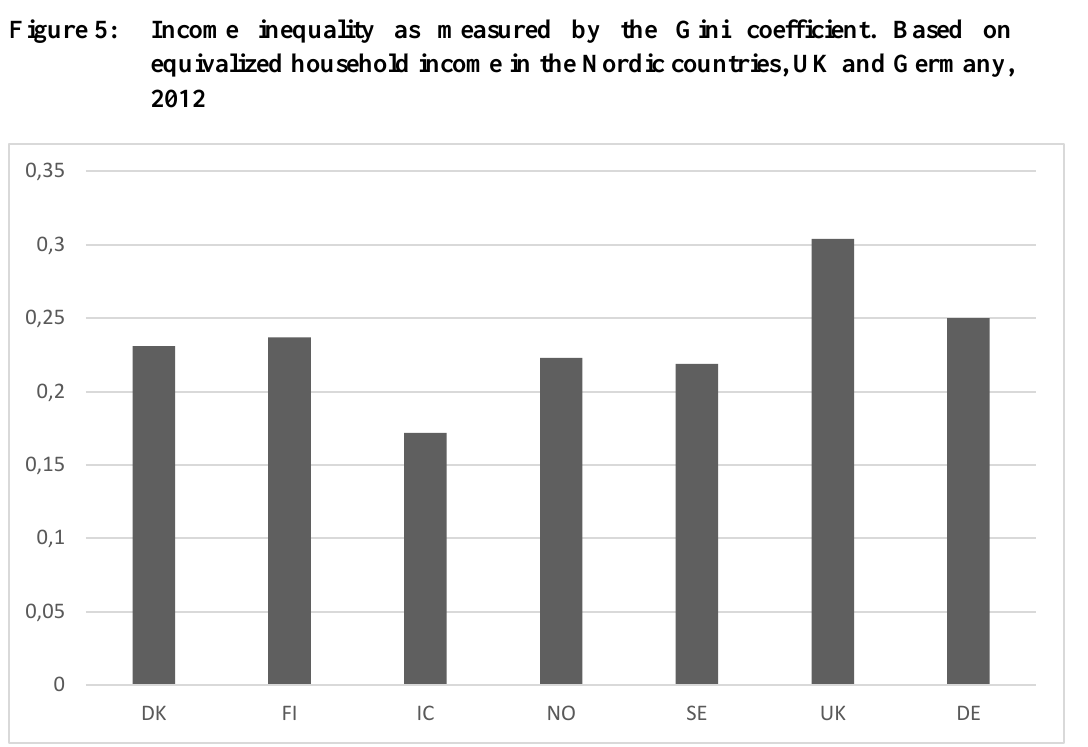
Source: European Social Survey 2012 (European Social Survey,